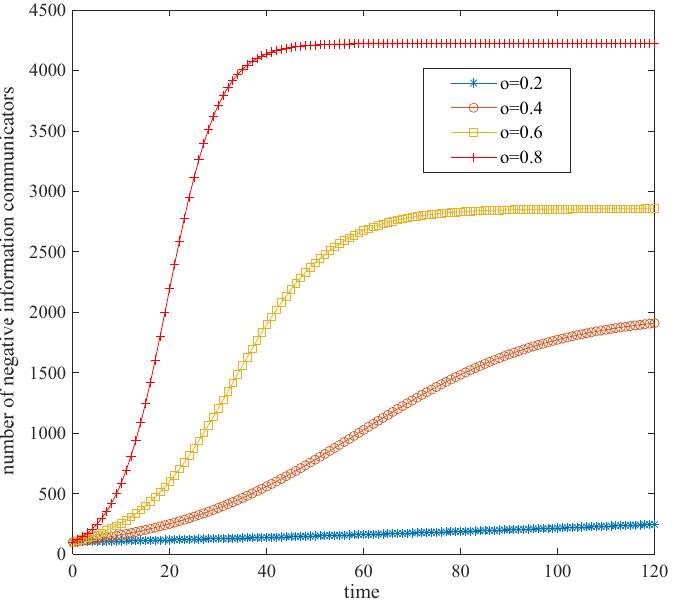
Figure 6. The spread of COVID-19 public opinion in neutral emotion tendencies.